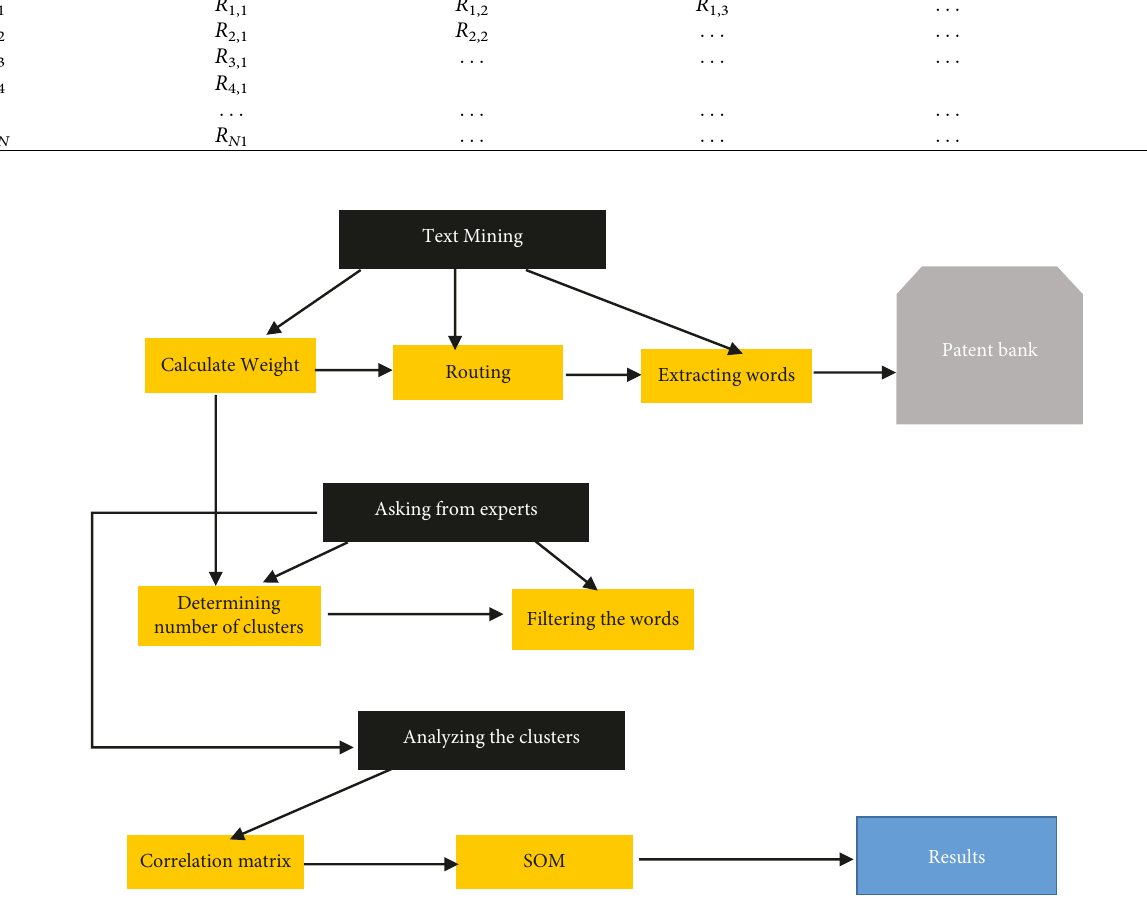
Figure 2: The general framework of the research